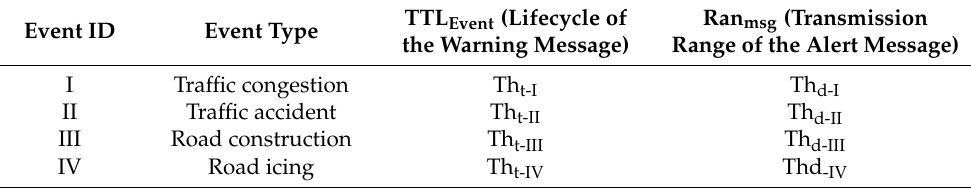
Table 1. Warning message report form.